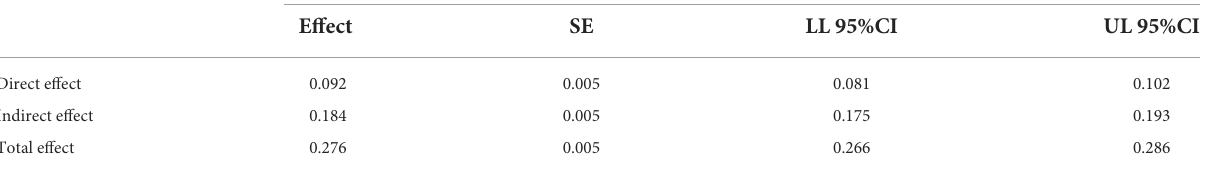
TABLE 3 Mediating model examination by